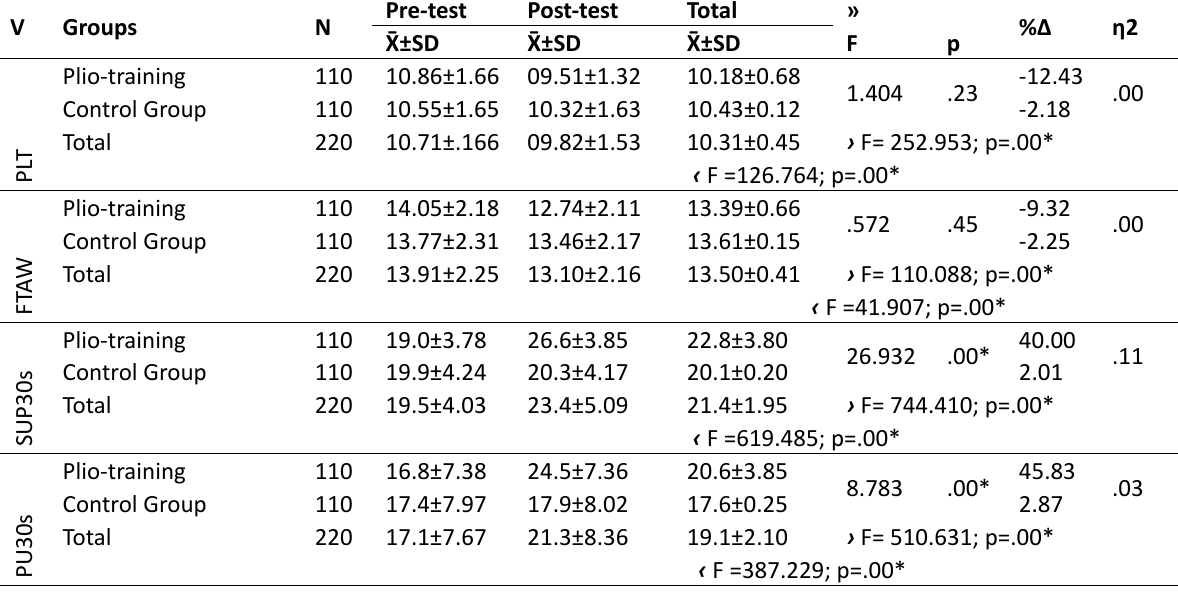
Table 5. Impact of plyometric training in the speed of the upper and lower extremities and endurance in force